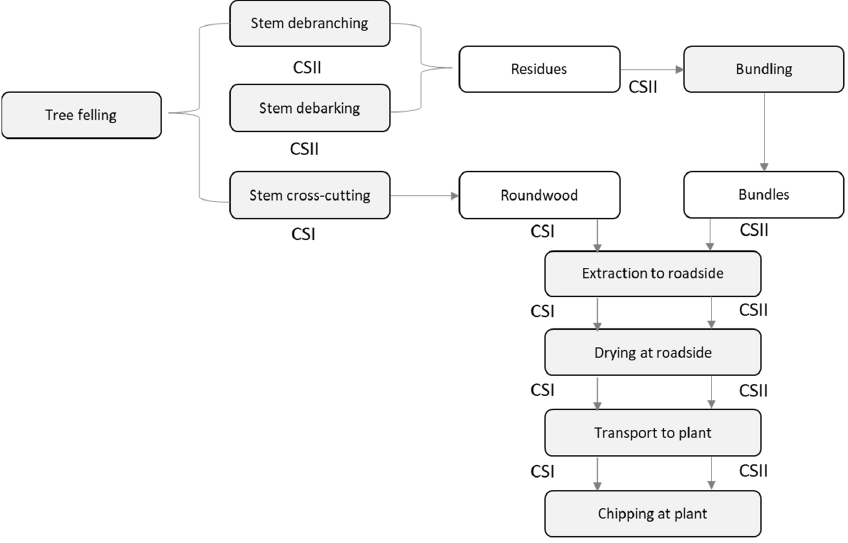
Figure 2. Supply chains SCI and SCII included in the study.